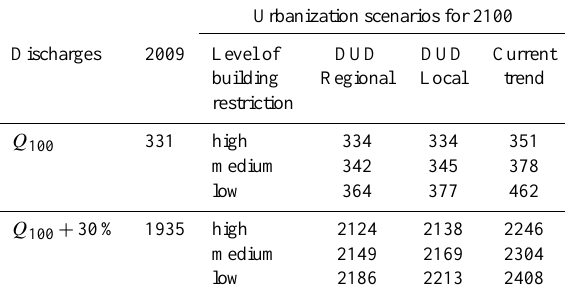
Fig. 14. Increase in residential areas between 2009 and 2100 within the 19 municipalities studied. (A) Detail by municipality, and (B) sum over the 19 municipalities. Table 4. Expected damages for a 100yr flood of the river Meuse in the Walloon region in 2009 (reference) and in 2100 (values in million euros). Building restrictions for 2100 are based on the available flood hazard map: high means no building in the high and medium flood hazard areas; medium, no building in the high flood hazard areas; low, no